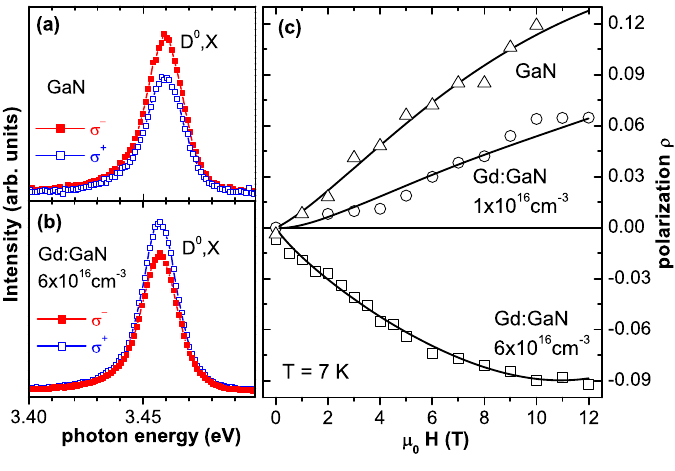
Figure 22. Circularly polarized photoluminescence spectra of the donor-bound exciton ( D 0 ; X ) for (a) a undoped GaN reference sample and (b) an GaN sample doped with 6 × 10 16 /cm 3 Gd. Both samples were measured at 7 K and 10 T in the Faraday configuration ( B ∥ c ). (c) Circular polarization (cid:26) of the ( D 0 ; X ) emission as a function of the external magnetic field at 7 K for the reference GaN sample (triangles) and two Gd:GaN films with 1 × 10 16 /cm 3 of Gd (circles) and the sample in (b) (squares). Data are from